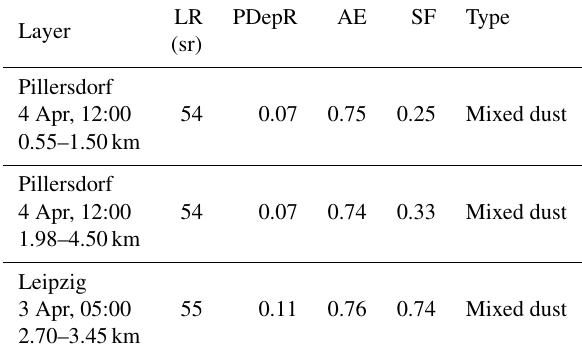
Table 6. Optical properties, sulfate fraction, and aerosol types for aerosol layers corresponding to Pillersdorf, 4 April 2014, 12:00. LR PDepR AE SF Layer